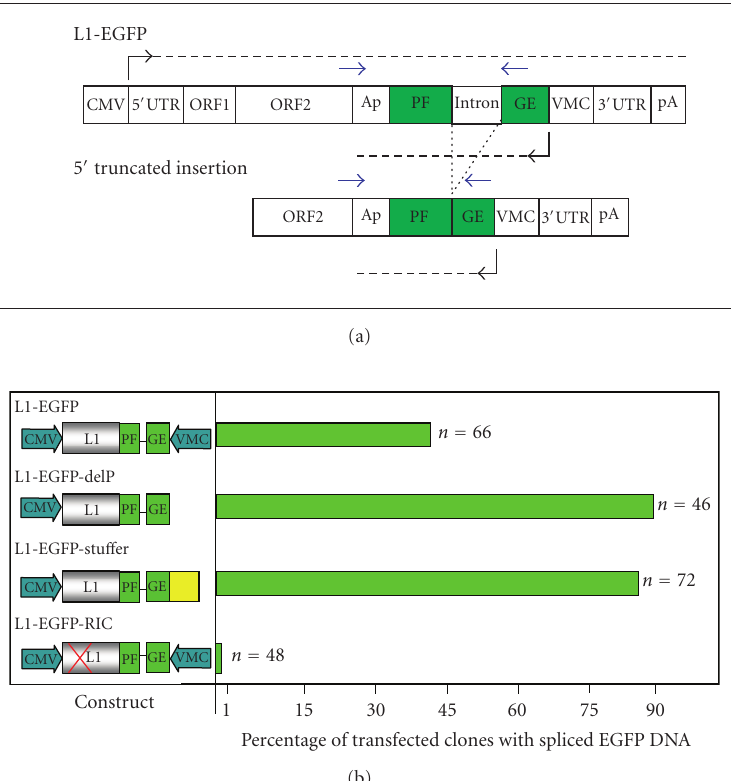
Figure 2: (a) The standard L1 reporter construct contains opposing promoters. The standard L1 reporter construct used in our laboratory (L1-EGFP) consists of the CMV promoter, the human L1 RP element, and the antisense EGFP gene cloned into the L1 3 (cid:2) UTR followed by the SV40 late poly-A sequence in pCEP4 (construct described in more detail in [51]). When L1-EGFP retrotransposes, a full-length L1 RNA is transcribed, the intron interrupting EGFP is spliced out, and the processed RNA is reverse transcribed, and a cDNA copy is inserted into the genome. If the insertion is of su ffi cient length and enters the genome in a transcriptionally permissive region, retrotransposition can be detected phenotypically by screening for EGFP expression. Retrotransposition can also be assayed genetically by performing PCR with primers that flank the EGFP intron. Because the EGFP marker is driven o ff of an antisense-oriented promoter relative to the L1, the potential exists for creating dsRNA. L1 and EGFP transcripts are given by dashed horizontal lines, promoters are denoted with black arrows, and blue arrows indicate intron-flanking primers used to distinguish new insertions from the parental L1. (b) Loss of an antisense promoter increases L1 retrotransposition in a cultured cell assay. 143B osteosarcoma cells were transfected with one of the following constructs as shown in Figure 2(a): L1-EGFP (the same wild-type L1 retrotransposition construct shown in Figure 2(a)), L1-EGFP-DelP (identical to L1-EGFP except that the CMV promoter driving EGFP was deleted), L1-EGFP-Stu ff er (identical to L1-EGFP except that the CMV promoter driving EGFP was replaced with a piece of DNA lacking promoter activity or polyadenylation signals), or L1-EGFP-RIC (retrotransposition incompetent due to two missense mutations (marked with a red X over the L1 coding sequence) derived from the JM111 L1 mutant [52]). Boxes indicate coding sequences except for the yellow box in the L1-EGFP-Stu ff er construct that denotes the stu ff er sequence. Arrows denote the promoters and the black line separating the EGFP cassette denotes the intron. Cells were selected in hygromycin for two weeks and individual clones were picked and expanded. PCR using primers that flank the intron/exon splice site in EGFP (as described in [11]) was used to monitor individual clones of antibiotic-resistant cells for L1 retrotransposition (loss of the intron in EGFP). The percentages of clones that had the spliced EGFP are shown in Figure 2(b). The number of clones surveyed for each genotype is given to the right of each of the bars. None of the retrotransposition incompetent L1 transfectants had a spliced EGFP